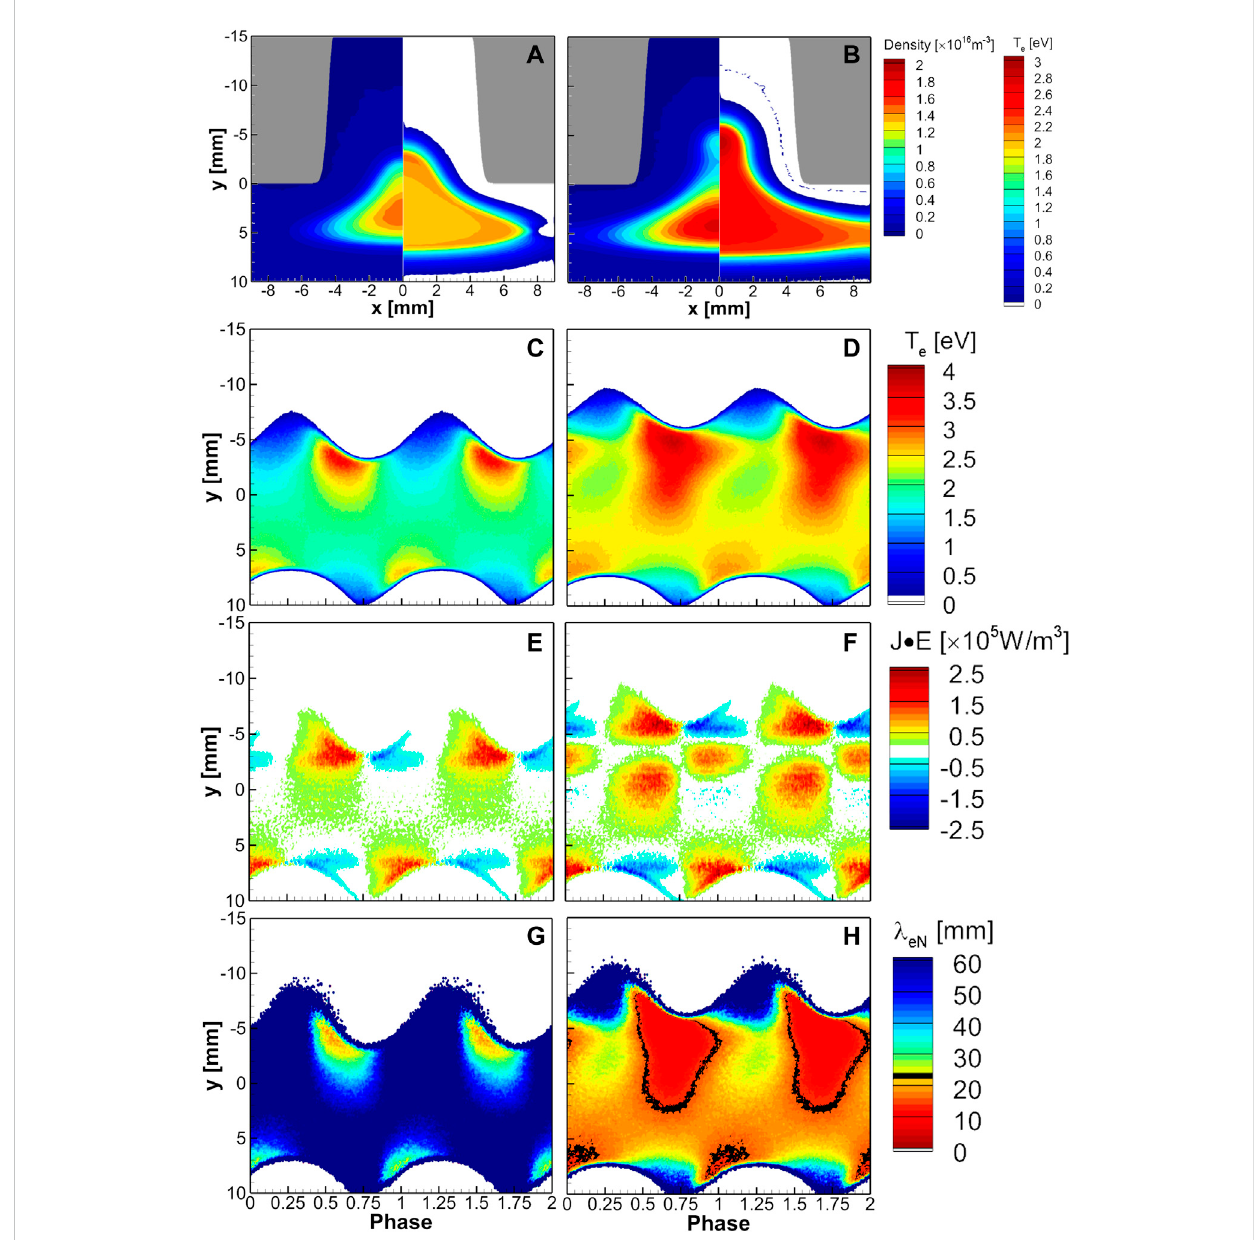
FIGURE 8 Shownaretime-averagedspatialpro fi lesofelectrondensity(leftside)andtemperature(rightside)undertheconditionsof d =8 mmand h =15 mm with Gaussian shape slope with a gas pressure of (A) 0.4 Torr and (B) 0.6 Torr. The phase-resolved spatiotemporal pro fi les at x = 0 position are provided for each case for (C) – (D) electron temperature, (E) – (F) electron power absorption, and (G) – (H) ensemble-averaged electron energy relaxation length, λ eN . The black line means the position with λ eN = 25